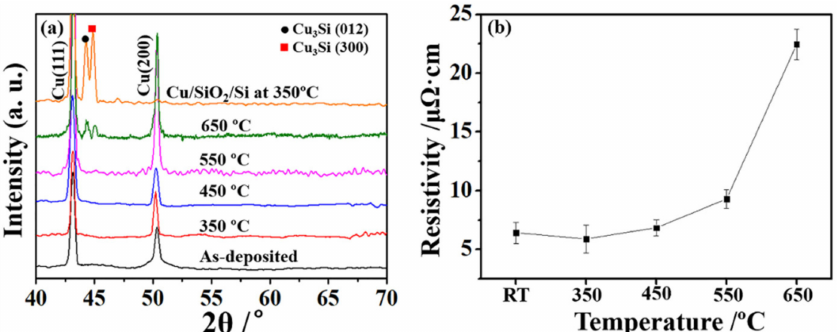
Figure 1. ( a ) The phase evolutions for Cu(Re)/SiO 2 /Si annealed at various temperatures and Cu/SiO 2 /Si annealed at 350 ◦ C. ( b ) Electrical results for Cu(Re)/SiO 2 /Si samples before and after annealing at various